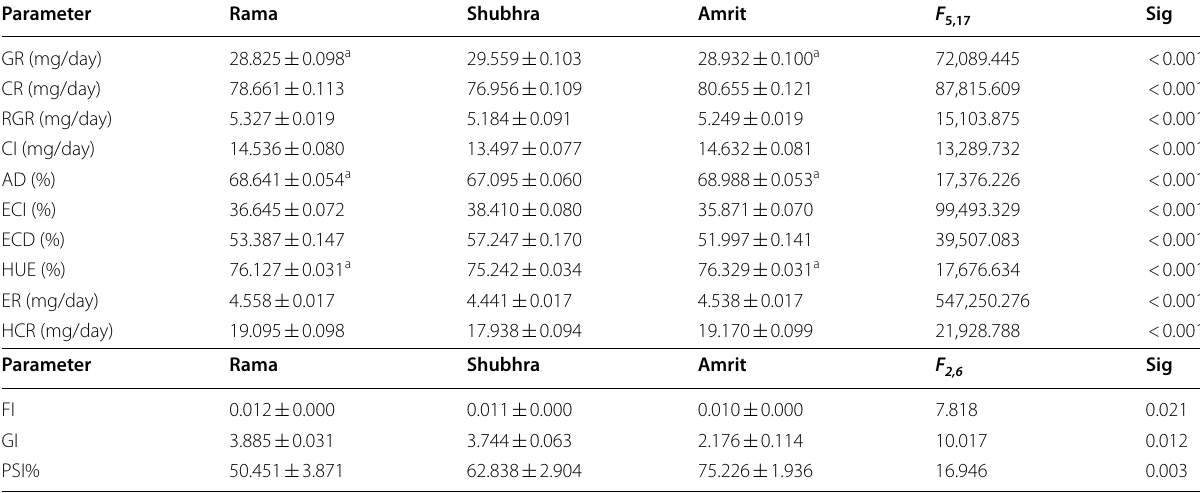
Within the rows means followed by same letter(s) are not significantly different at P < 0.05 by Tukey’s (HSD) test along with F values (ANOVA)